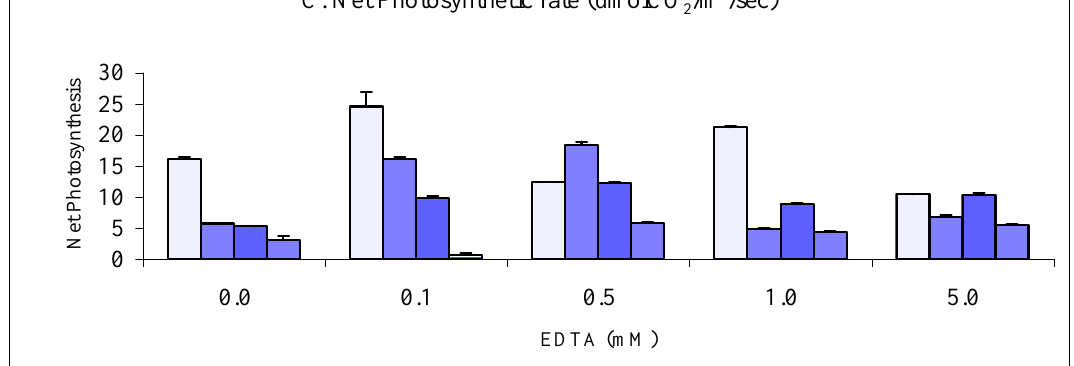
Fig. 1: Effects of various concentrations of Pb and EDTA on (A) stomatal density, (B) total chlorophyll, and (C) the net photosynthetic rate of Ipomoea lacunosa (L.). Vertical bars indicate standard error of the mean of 4